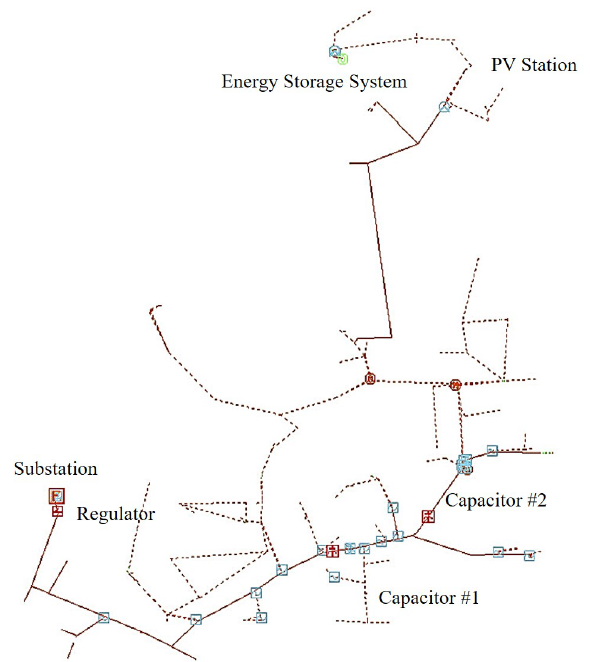
Figure 3. The configuration of the modeled industrial